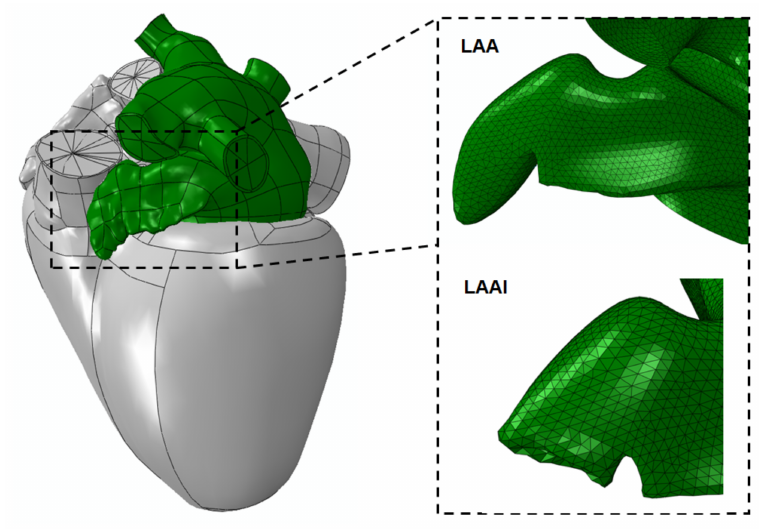
Figure 2. LA model (green) as extrapolated from the LHHM (grey); insertions show LAA mesh at undeformed and deformed